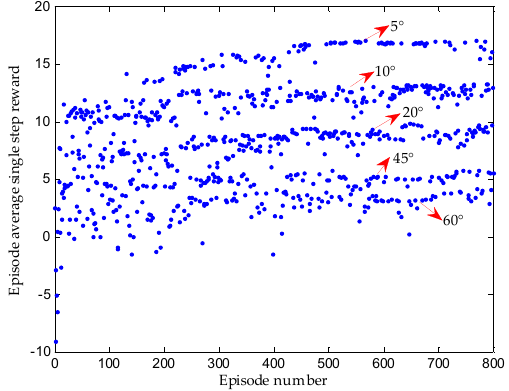
Figure 15. Extended training of other initial angles based on 30° well-trained network.